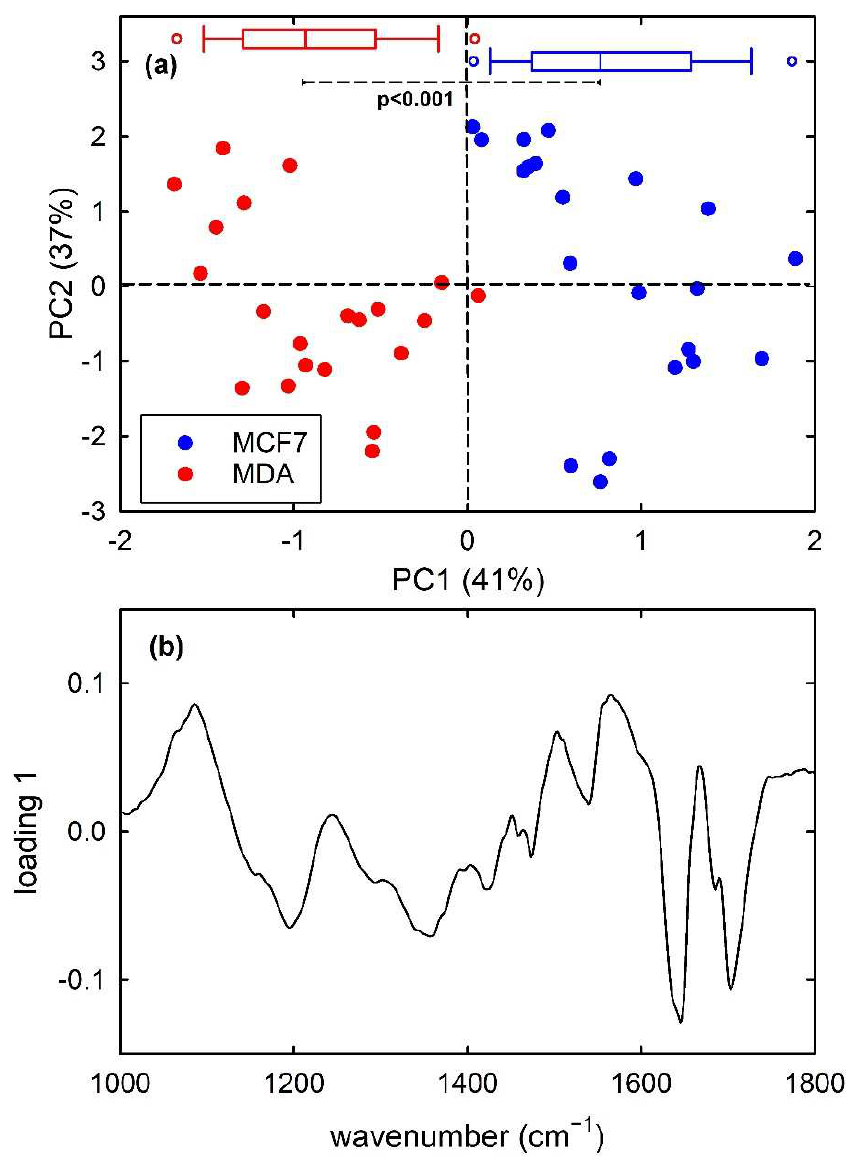
Figure 6. PC2 vs. PC1 score plot ( a ) for the MCF7 (blue dots) and MDA (red dots) FTIR spectra. The box plots of the PC1 score values are shown at the top of ( a ): the results of the t -test point out that the two distributions of score values are significantly different ( p < 0.001). Loading 1 spectrum is reported in ( b ).